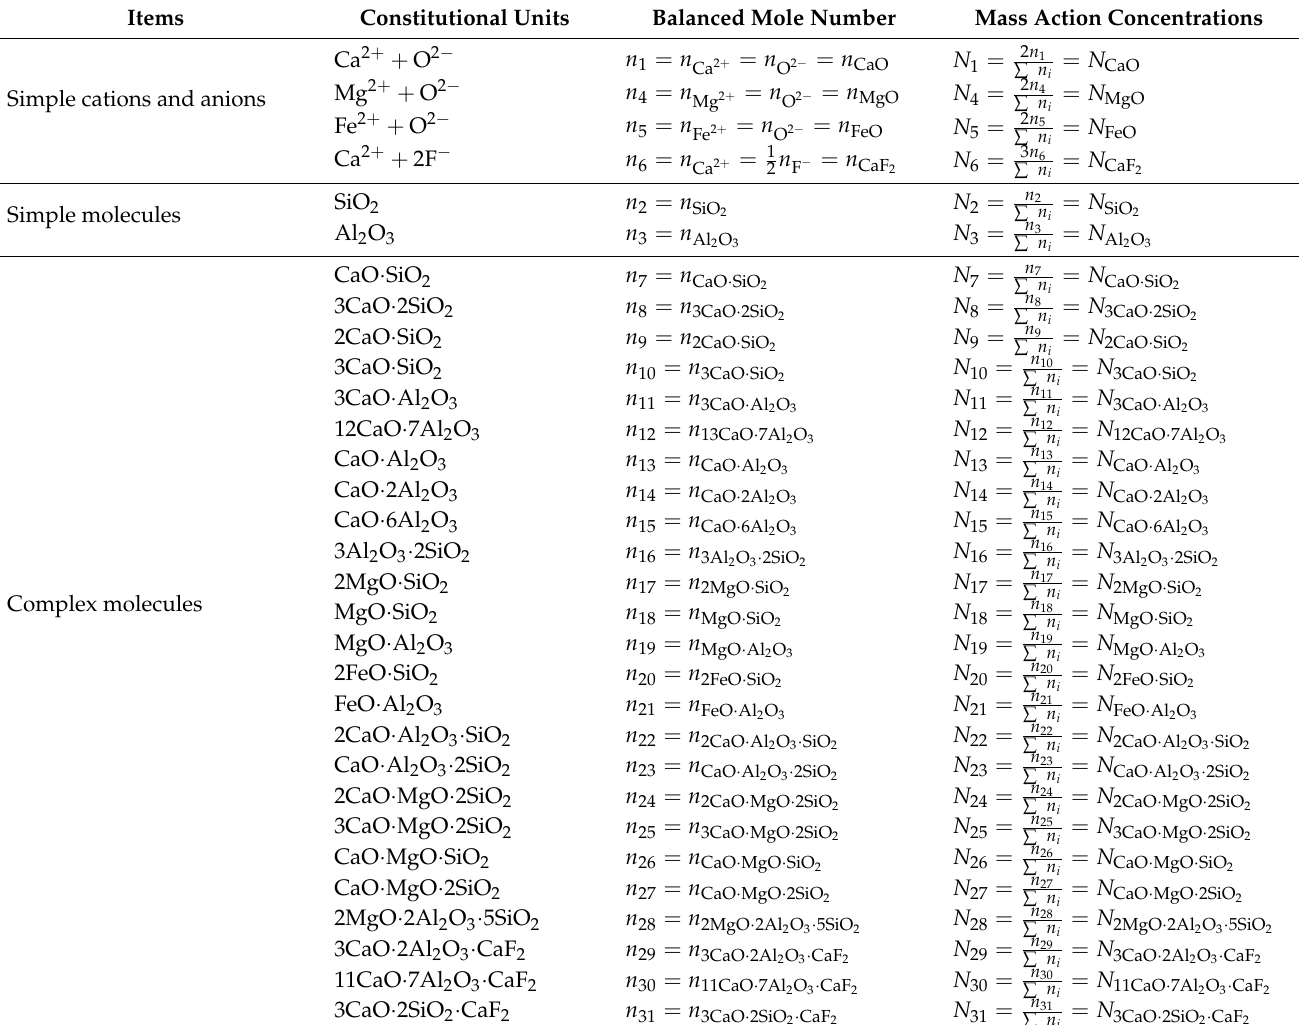
Table 3. Parameters of structural units in the slag